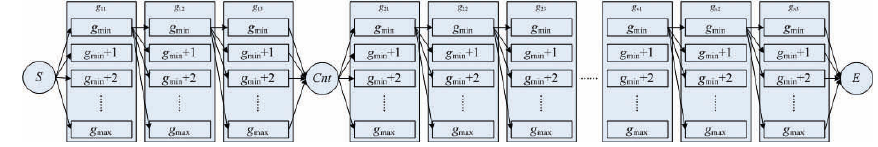
Figure 3. Solution space of the upper